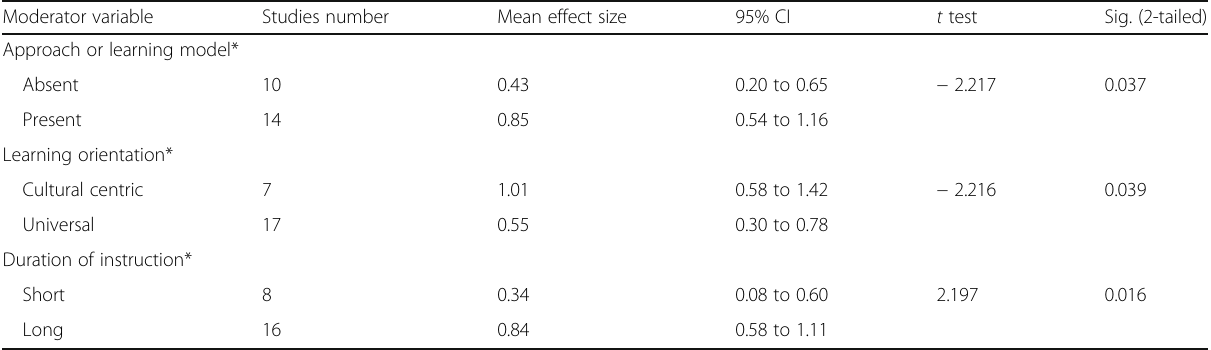
Table 2 Moderator variable analysis of academic learning achievement Moderator variable Studies